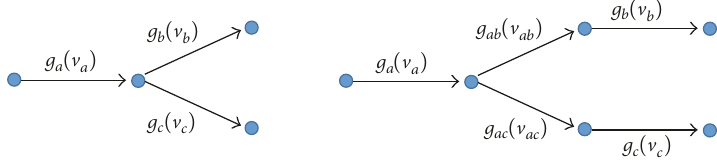
Figure 2: Network representation for addressing intersection